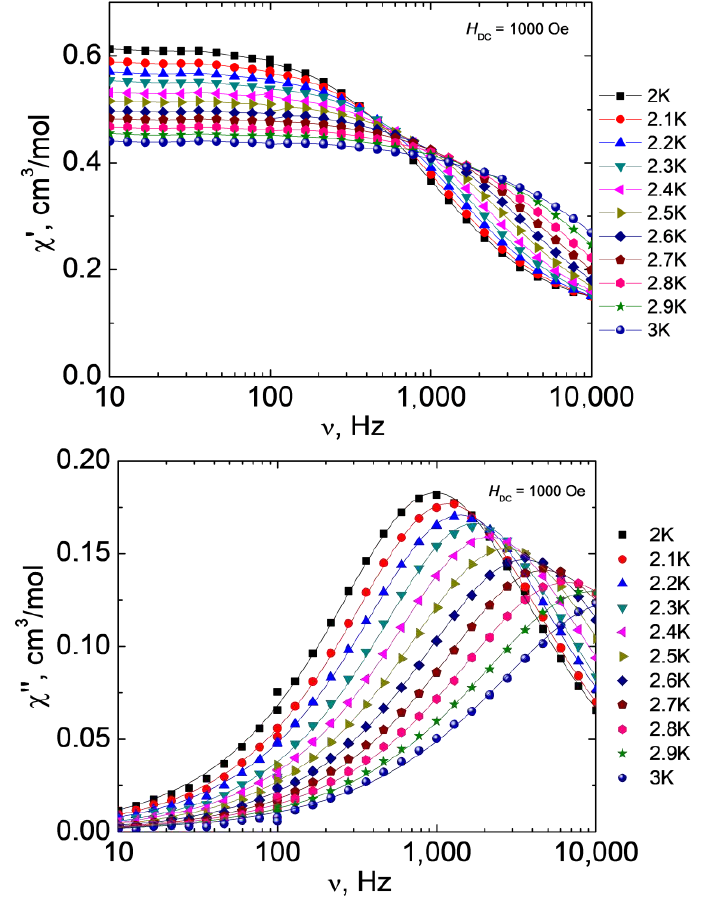
Figure 8. Frequency dependences of the real ( χ ’, top) and imaginary ( χ ”, bottom) parts of the ac magnetic susceptibility at different temperatures for 1 at H = 1000 Oe, T = 2‒3 K. Lines show approximations of the data by the generalized Debye model.